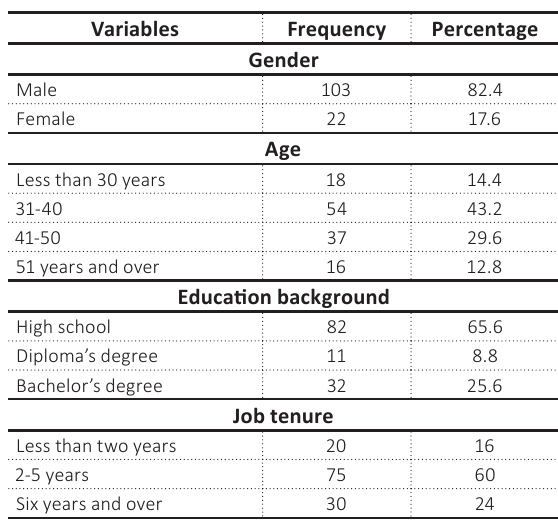
Table 1. Descriptive statistics of the